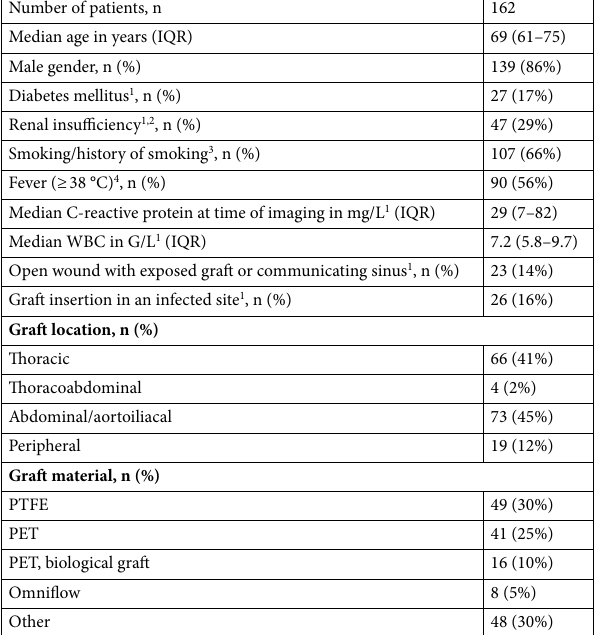
Table 1. Patient demographics at the time of the baseline PET/CT. PET/CT positron emission tomography/ computed tomography, IQR interquartile range, WBC white blood cell count, PTFE polytetrafluoroethylene, PET polyethyleneterephtalat. 1 Data of two patients missing. 2 Defined as glomerular filtration rate < 50 ml/min. 3 Data of 10 patients missing. 4 Data of four patients